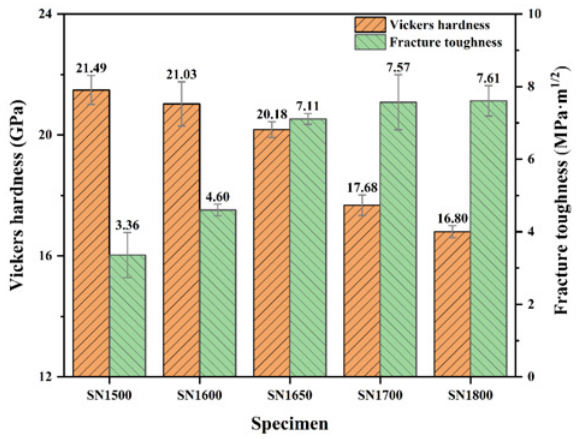
Fig. 3 Vickers hardness and fracture toughness of the SPSed Si 3 N 4